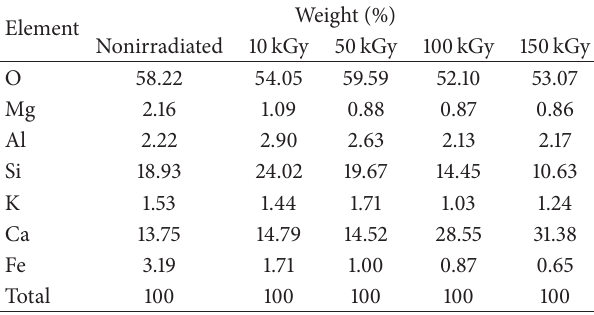
Table 1: EDS analysis of nonirradiated and irradiated minerals.